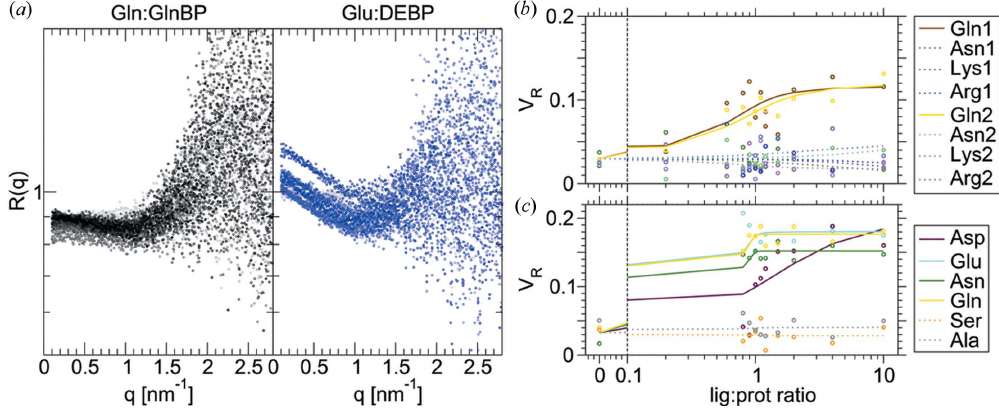
Figure 6 Summary of SAXS-based screening performance on GlnBP and DEBP. ( a ) Ratio curves of R ( q ) for the titration between GlnBP and DEBP with its cognate ligands Gln and Glu, respectively. ( b ) V R curves for the prospective screening trial of GlnBP with native and other amino acid targets. ( c ) V R curves for the prospective screening trial of DEBP with native and other amino acid targets. For comparison, equivalent curves using other metrics are shown in Fig.